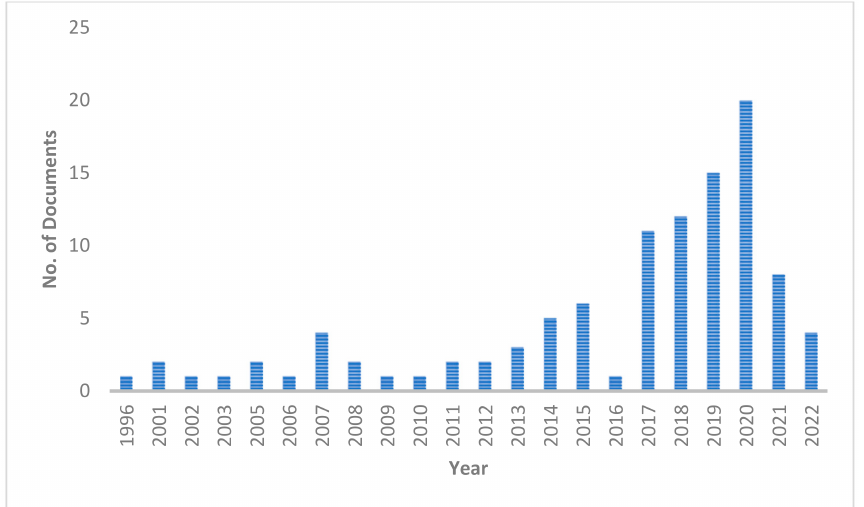
Figure 3. Number of relevant papers on BIM, point-cloud processing and BIM standards published each year between 1996 and 2021.